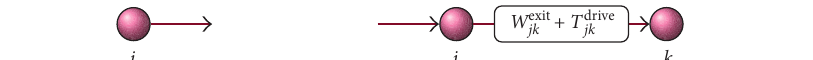
Figure 7: Network representations of the entry module (a) and the exit module (b). At node i in the entry module, vehicles are generated. At node j in the exit module, a vehicle will initiate a combined waiting and driving activity. The waiting time is denoted W exit jk